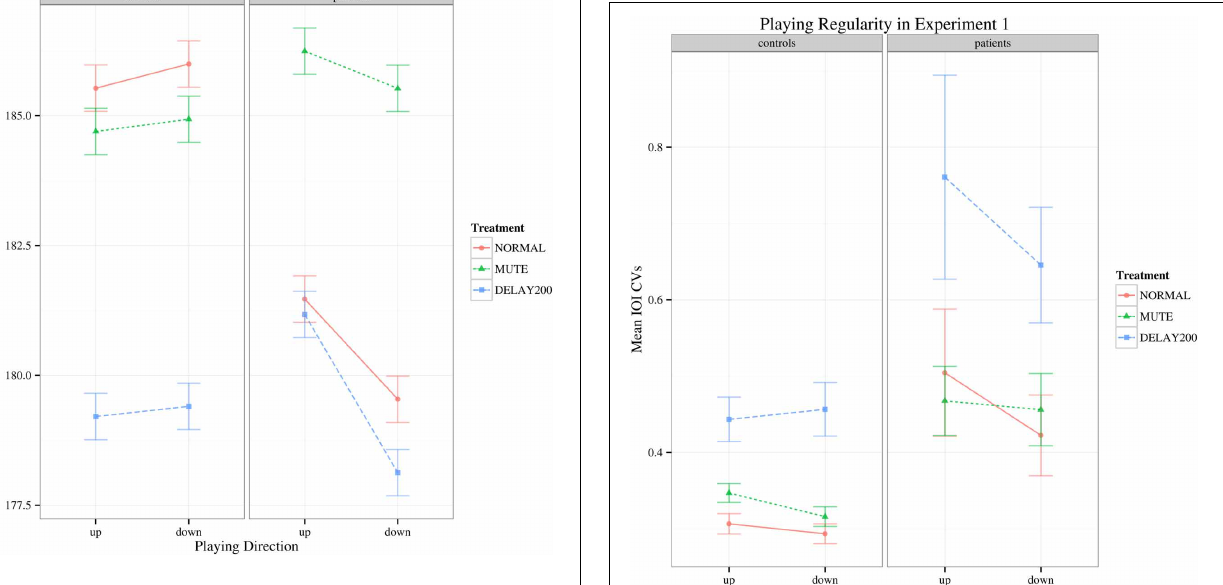
FIGURE 1 | Interaction plot of mean IOI’s for Experiment 1. Shown are the estimated mean IOIs (ms) conditional on group membership and auditory manipulation, collapsed over playing direction. Error bars denote 95% confidence intervals.